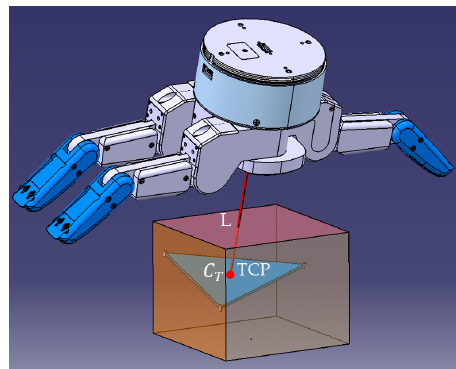
Figure 5. Intersection of the hand’s Tool Center Point (TCP) with the center C T of the grasp triangle.